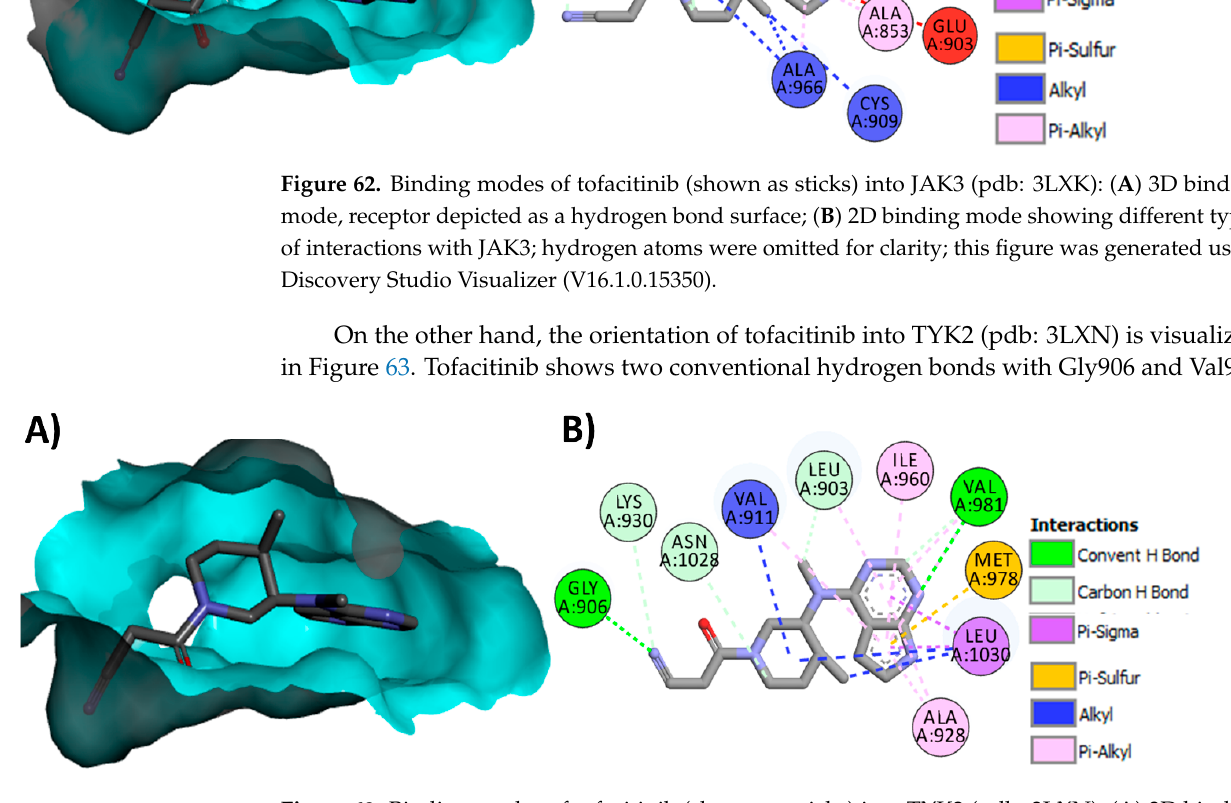
Figure 63. Binding modes of tofacitinib (shown as sticks) into TYK2 (pdb: 3LXN): ( A ) 3D binding mode, receptor shown as a hydrogen bond surface; ( B ) 2D binding mode showing different types of interactions with TYK2; hydrogen atoms were omitted for clarity; this figure was generated using Discovery Studio Visualizer (V16.1.0.15350).